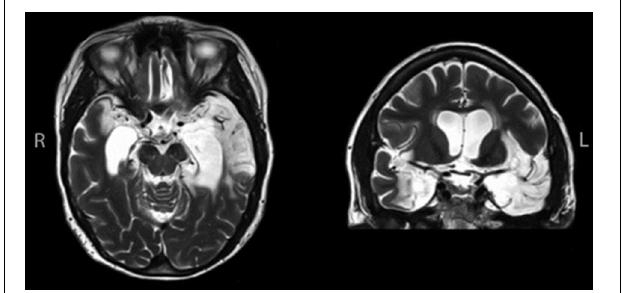
FIGURE 1 | High resolution magnetic resonance images showing the extent of temporal lobe damage in patient LSJ. See text for description of